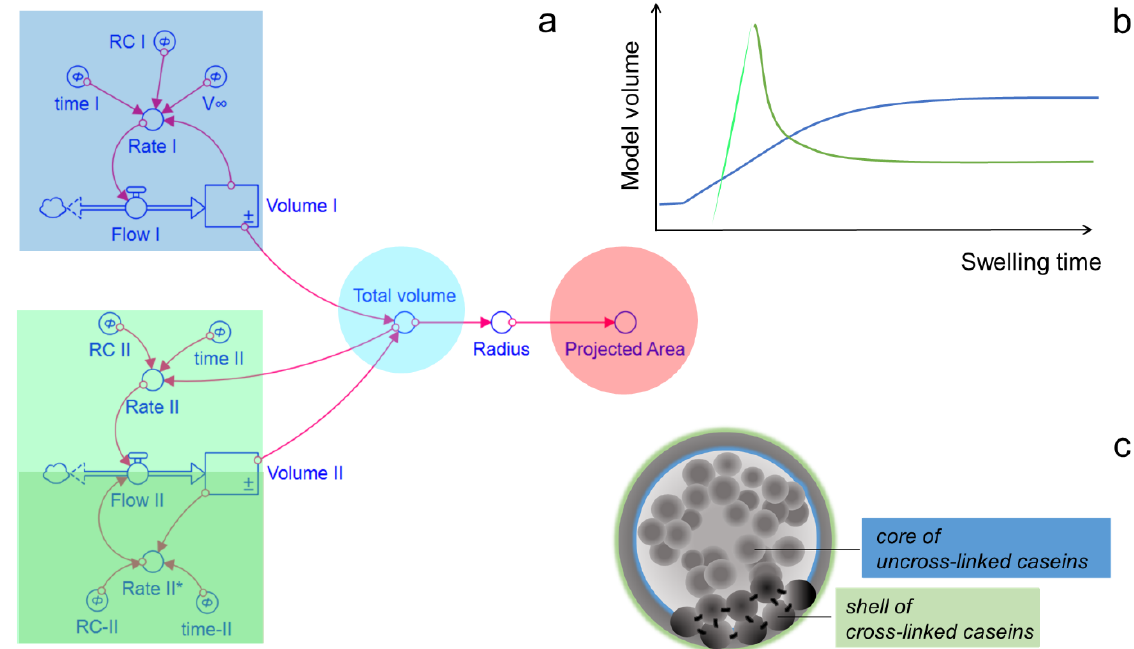
Figure 4. Analysis of the swelling process of CMPs treated with TGase. ( a ) Parallel system dynamics model; ( b ) Time course of the different swelling fractions and ( c ) schematic representation of the CMPs consisting of a core of uncross-linked and a shell of cross-linked caseins (Not true to scale).